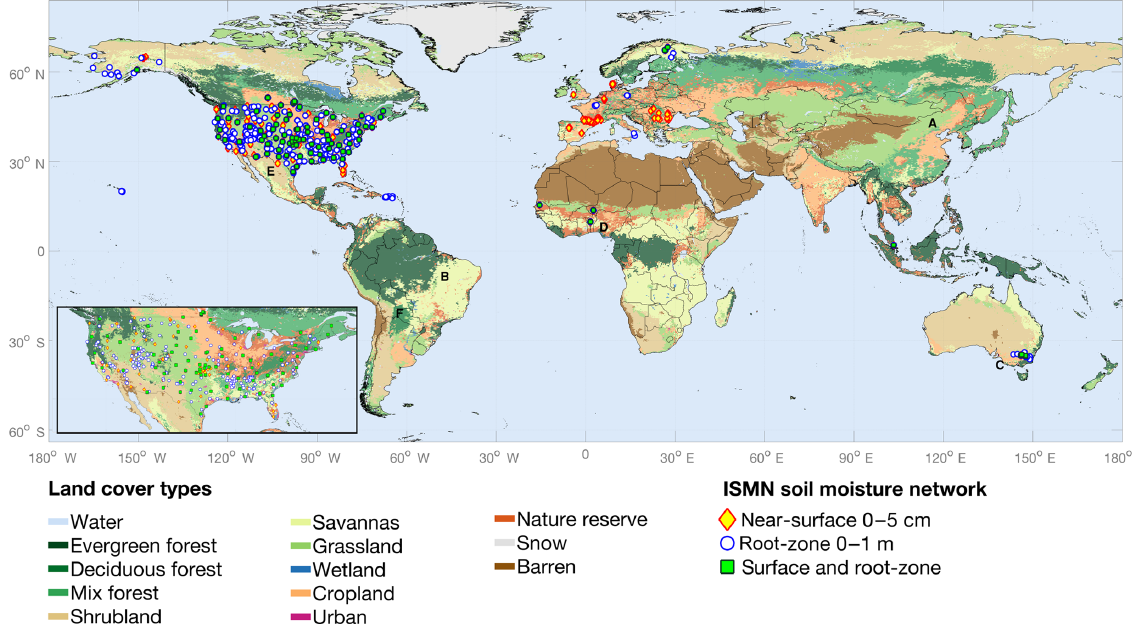
Figure 2. Distribution of in situ near-surface and root-zone soil moisture sites from the International Soil Moisture Network (ISMN) overlaid on the background of MODIS IGBP (International Geosphere-Biosphere Programme) land cover classifications (MCD12Q1).